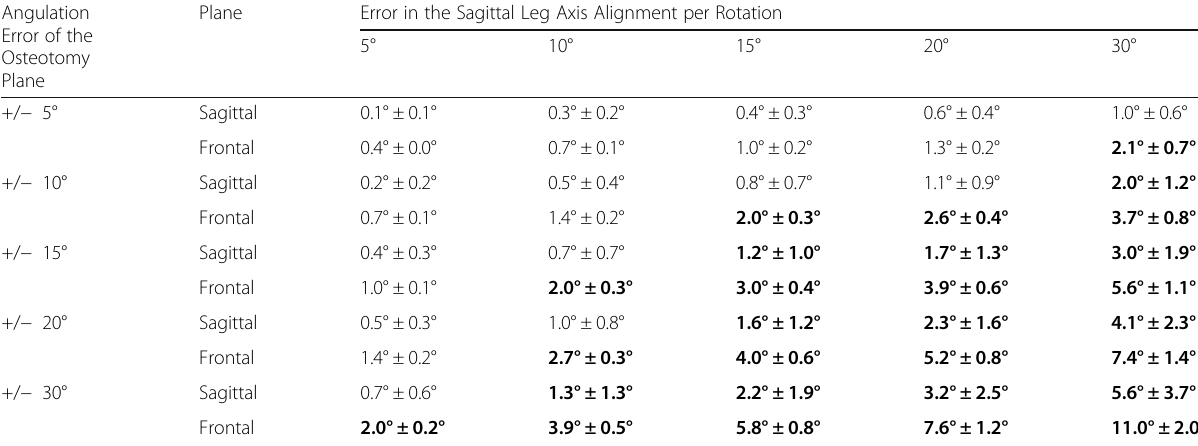
Table 2 Absolute mean deviations from the preoperative sagittal mechanical leg axis in supracondylar rotational osteotomies Angulation Plane Error of the Osteotomy Plane